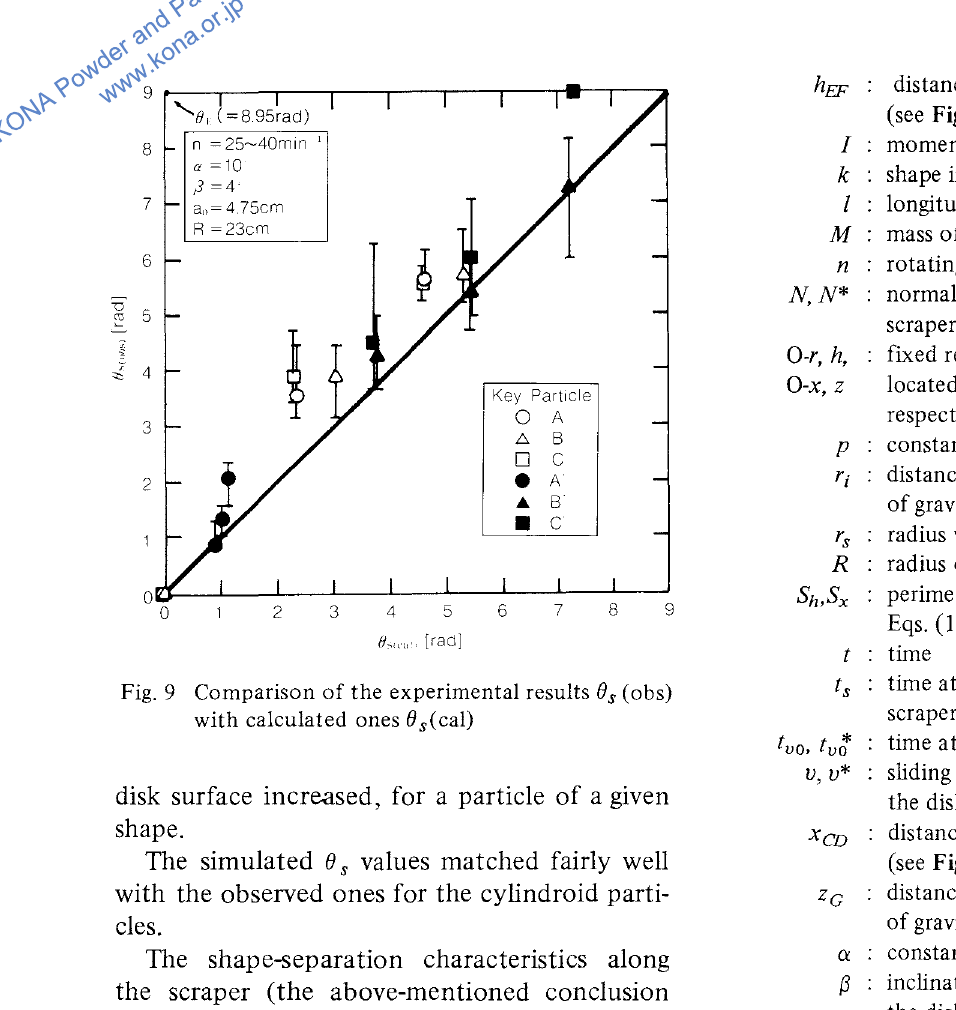
Fig. 9 Comparison of the experimental results es (obs) with calculated ones